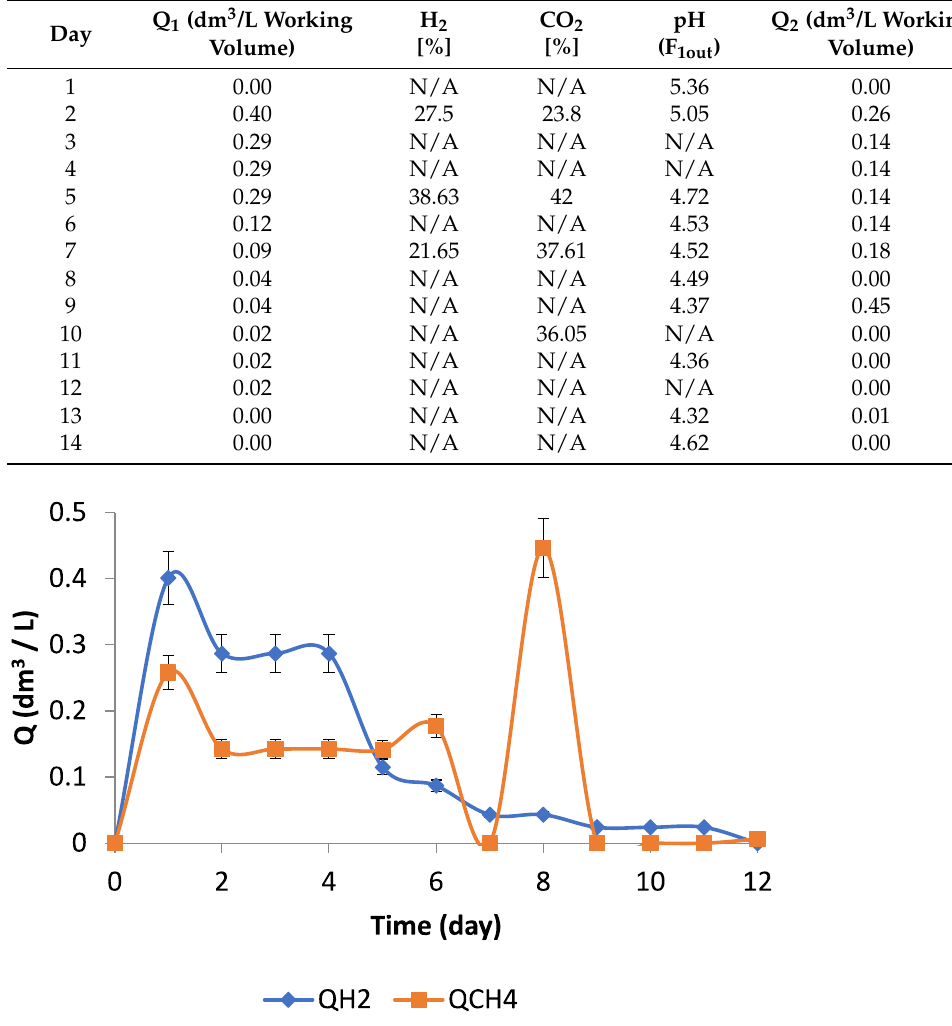
Figure 6. Dynamics in biogas production from two-phase anaerobic digestion with hydrogen (BR 1 ) and methane (BR 2 )